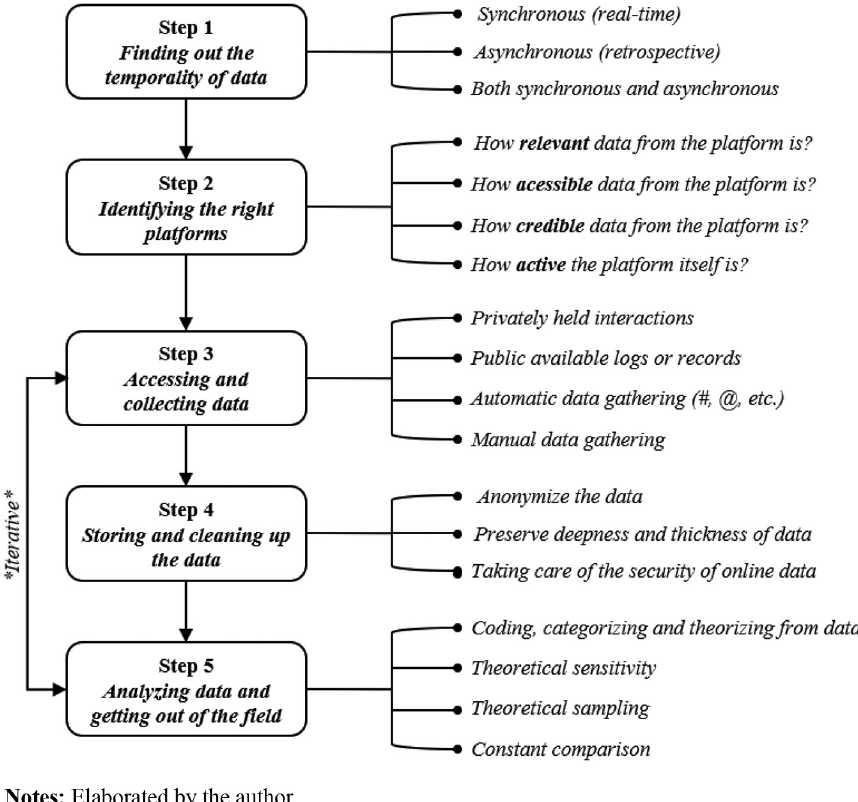
Figure 1. Step-by-step guide for grounded